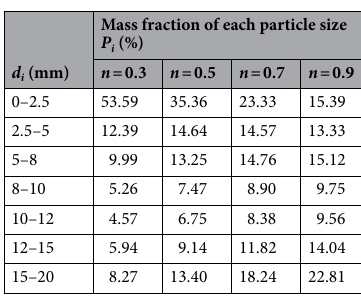
Table 1. Mass fraction of each particle size of the samples.